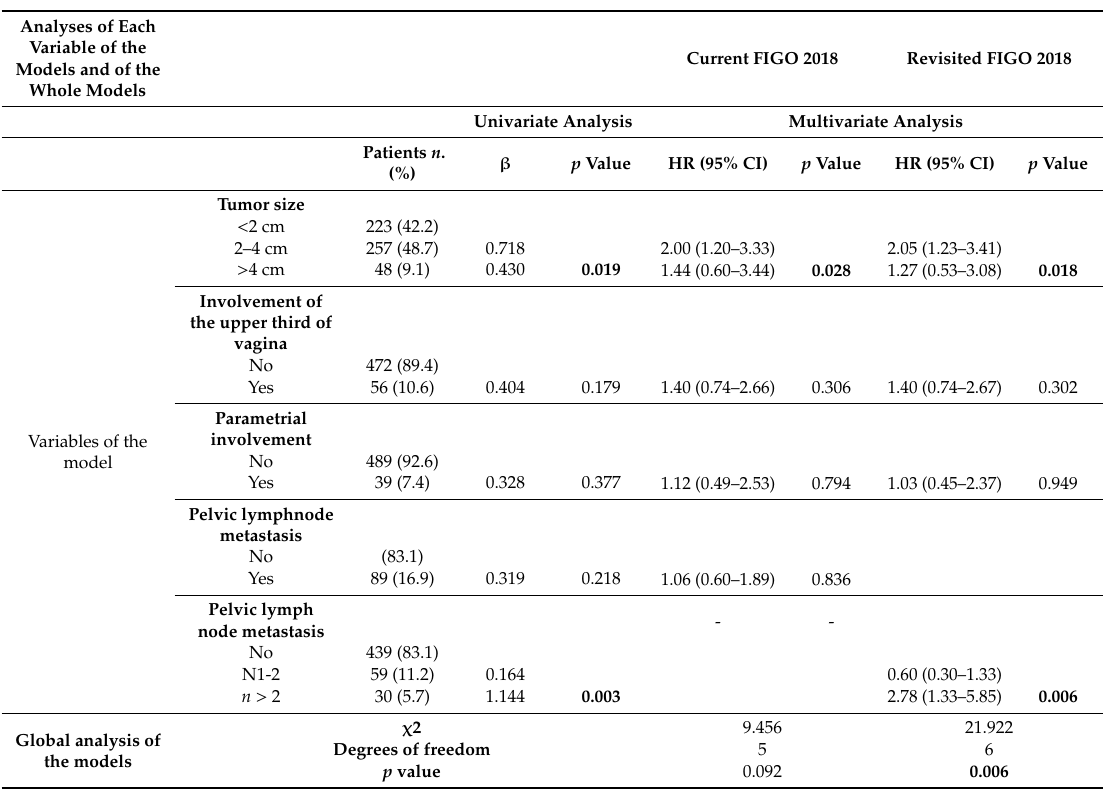
Table 3. Comparison of predictive models for disease free survival based on current FIGO 2018 staging versus the revisited FIGO 2018 stage, which stratifies the N1–2 and the n > 2 groups within the IIIC1p stage. Bold p values indicate statistical